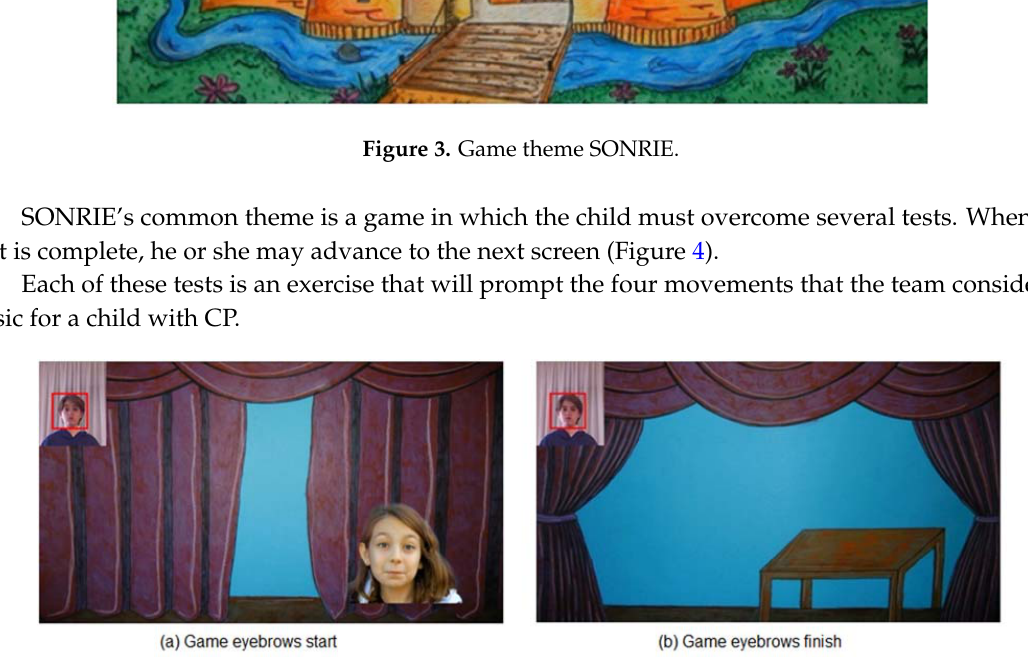
Figure 4. Game scenarios SONRIE. Eyebrow raising game.